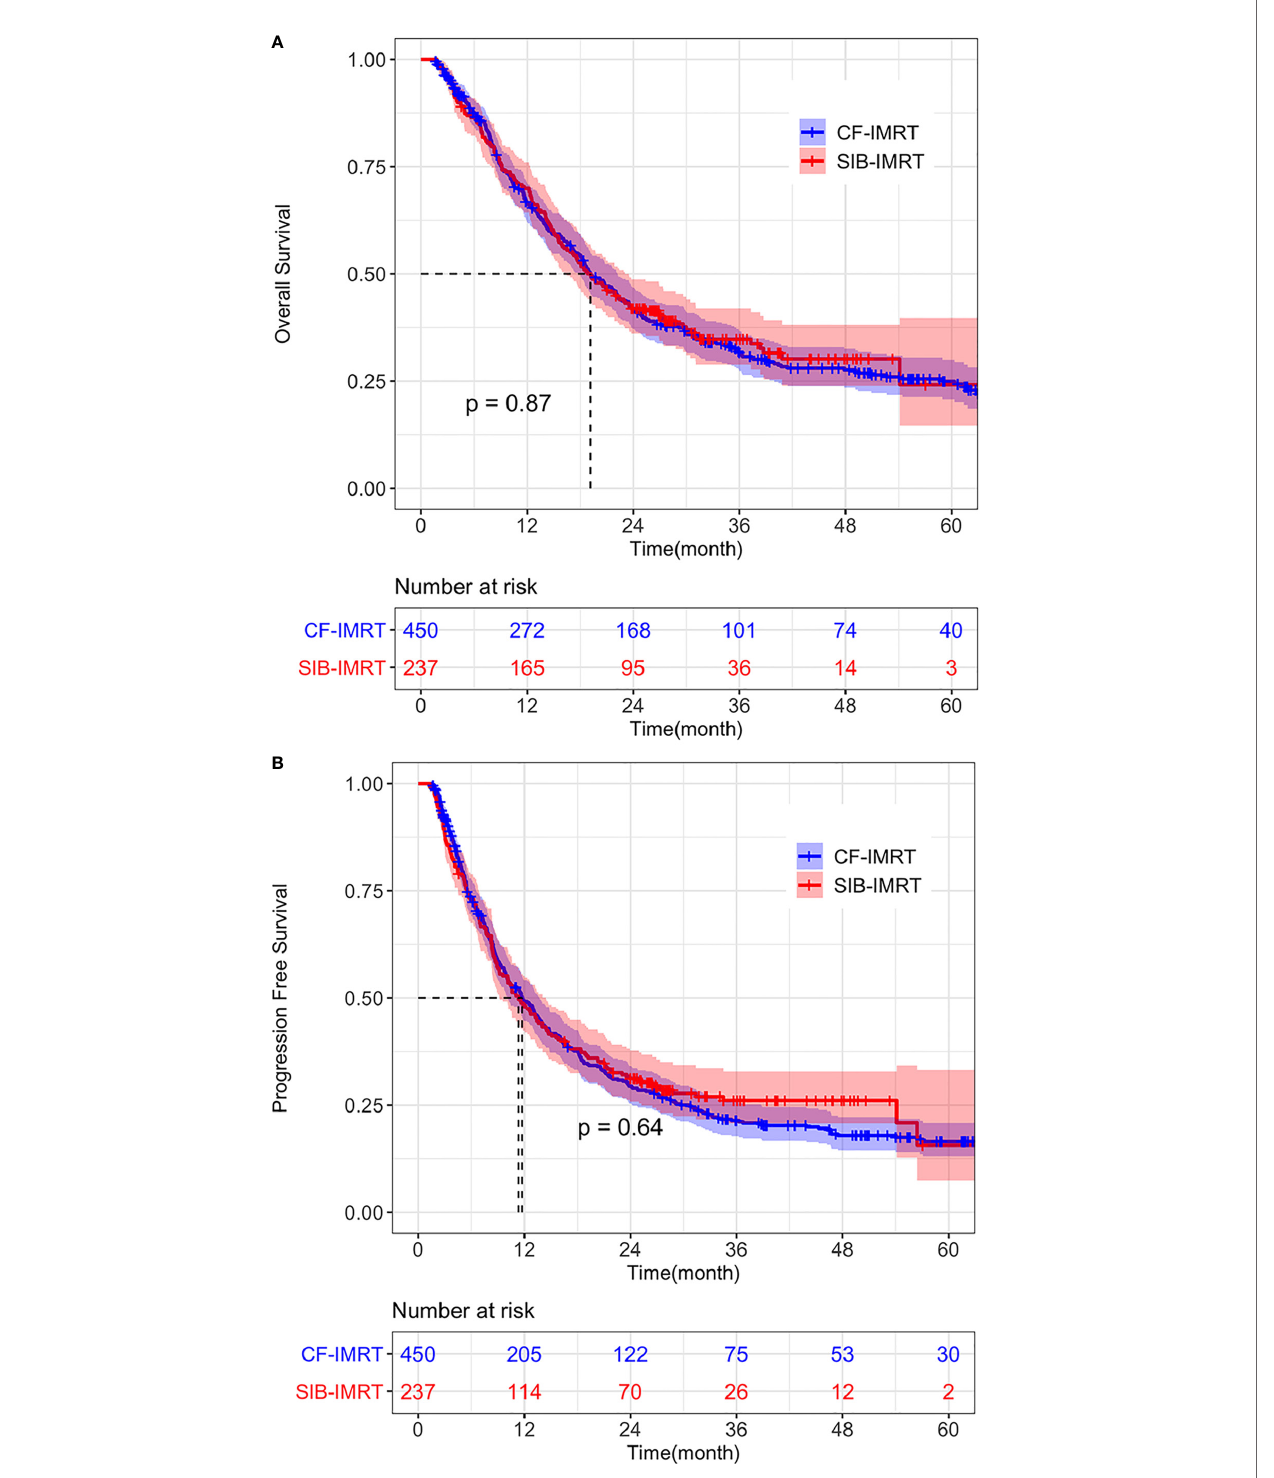
FIGURE 2 | Overall survival (OS) and progression-free survival (PFS) of SIB-IMRT and CF-IMRT treated patients. Kaplan – Meier (KM) estimates of (A) OS after PSM, with 95% CIs. (B) PFS after PSM, with 95%